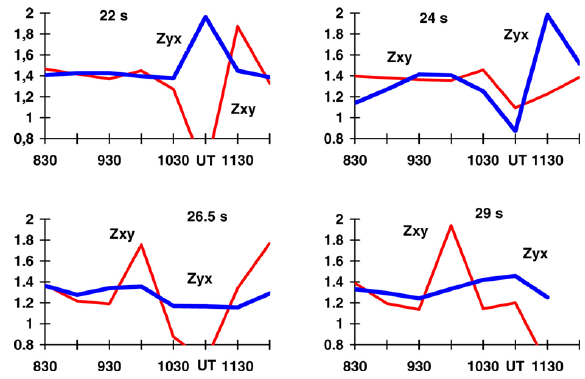
Fig. 4. MT impedance elements at NCK on August 11, 1999, on the eclipse day around the totality in 30 min intervals for periods 22-29 s. Red line is Zxy, blue Zyx.